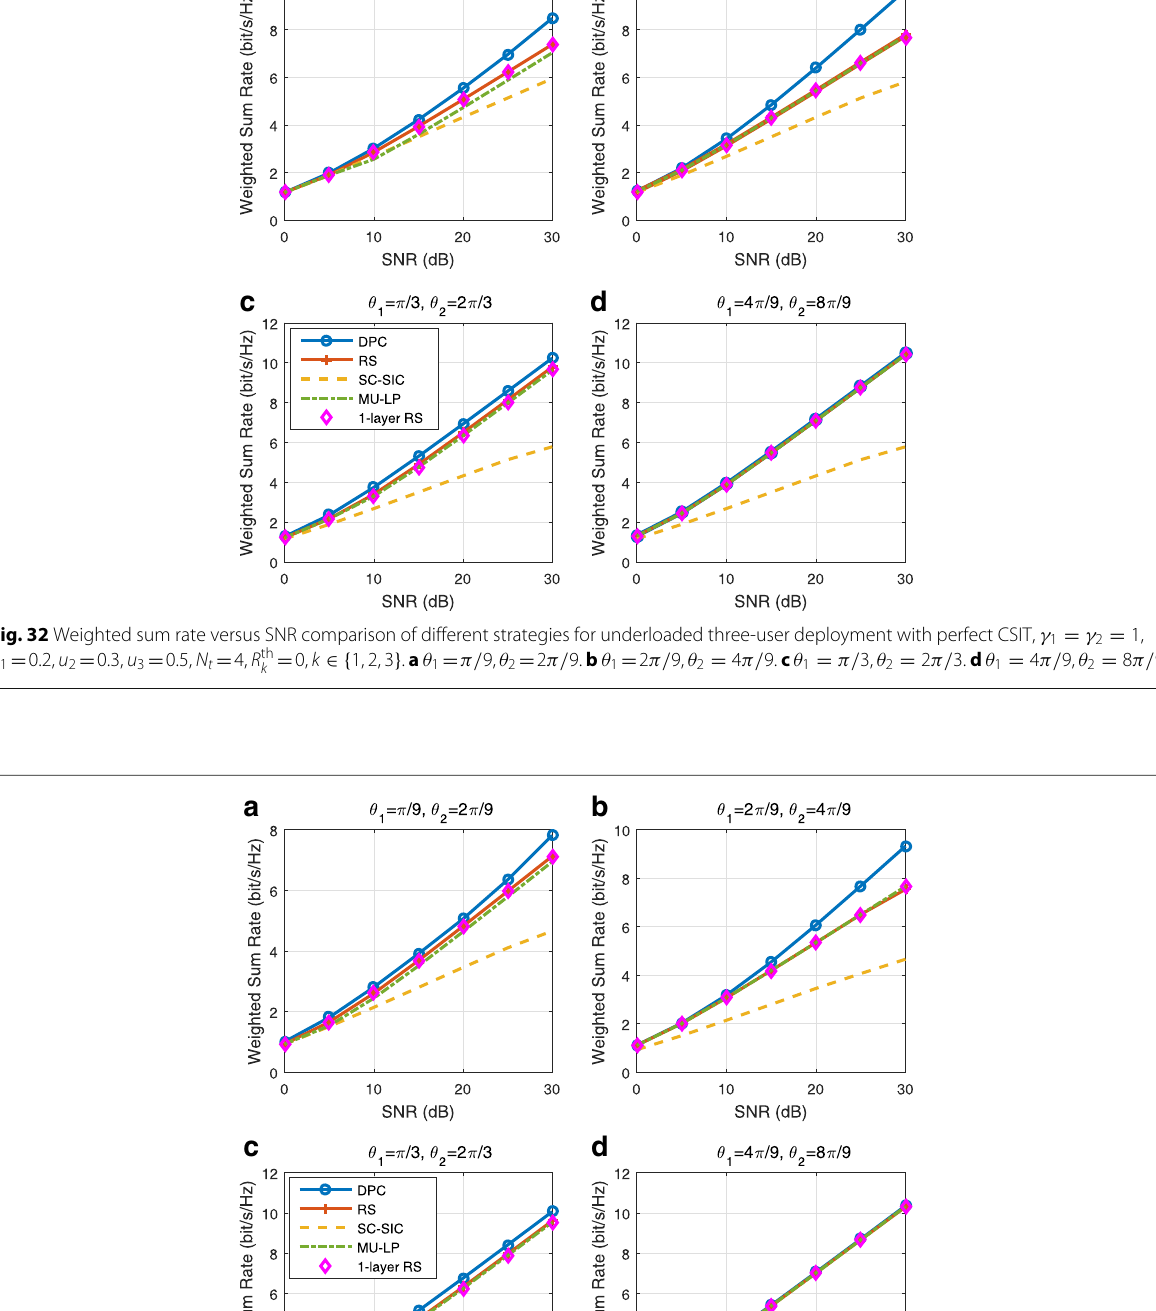
= 0, k ∈ { 1,2,3 } . a θ k